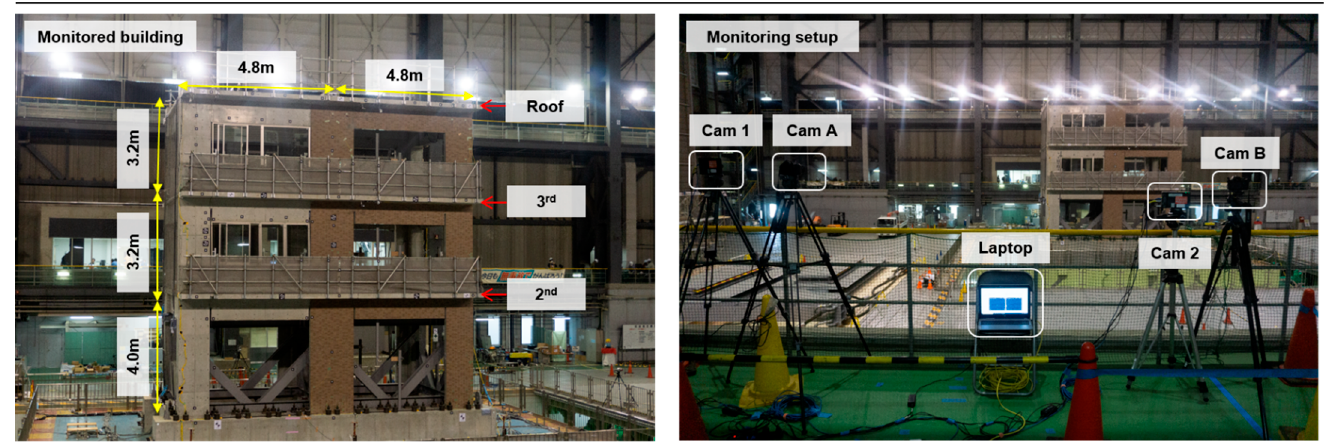
Figure 7. Seismic shake table test monitoring setup using two vision ‐ based sensor systems. Table 7. Vision ‐ based system configuration using two sets of cameras for the seismic shake table test.